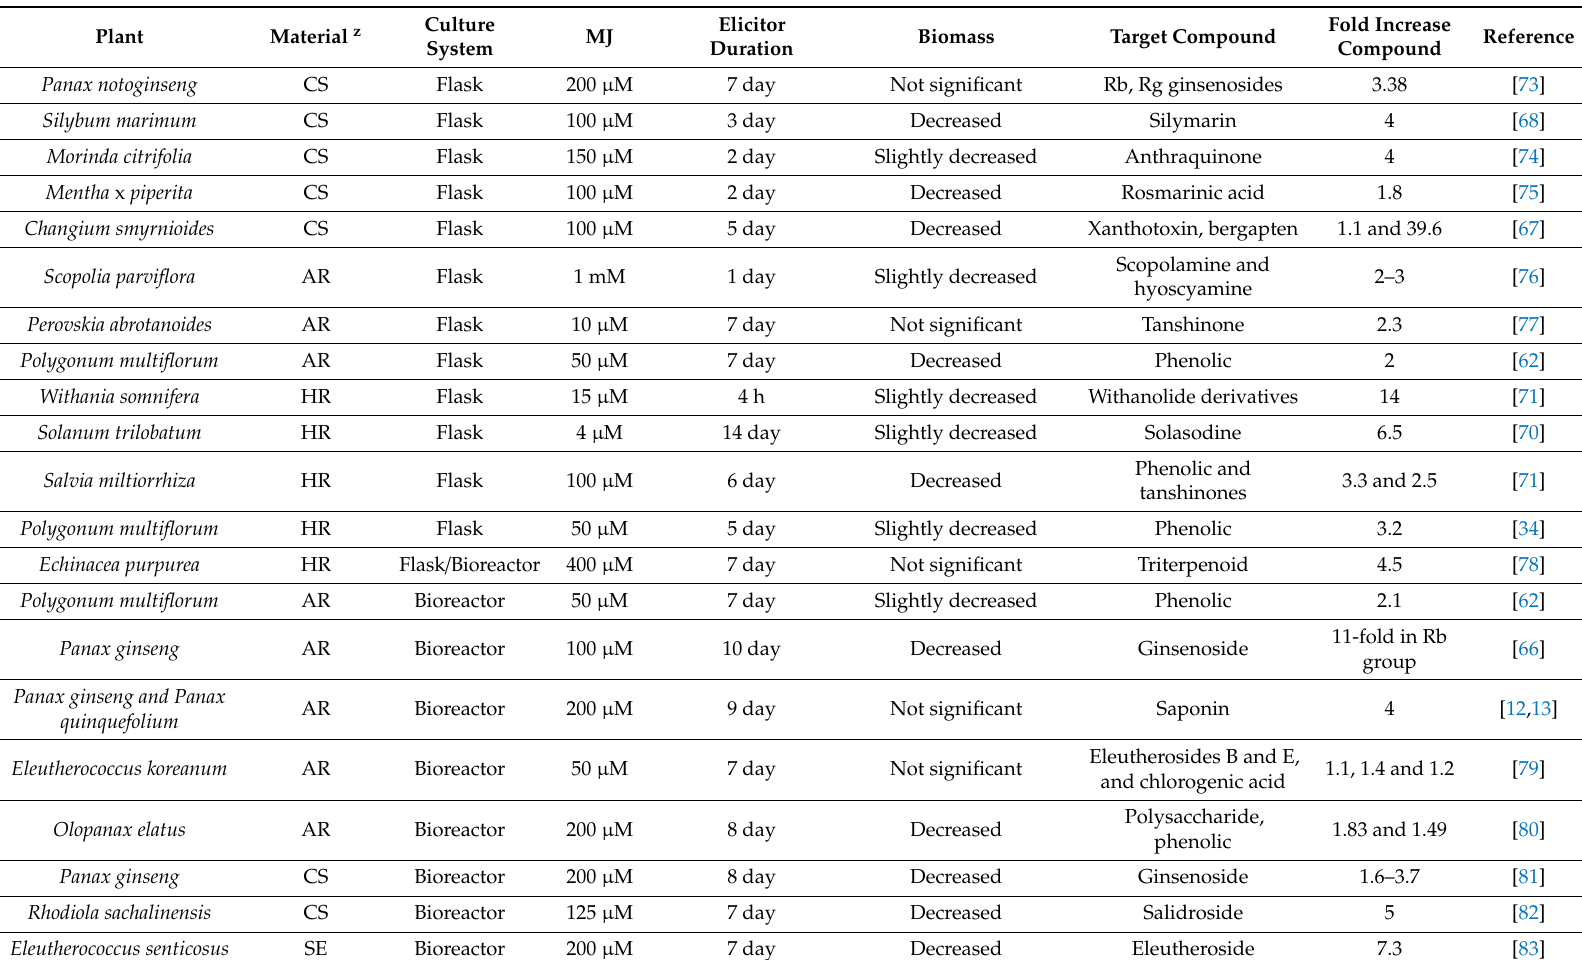
Table 1. Usage of MJ for enhance secondary metabolite within in vitro culture